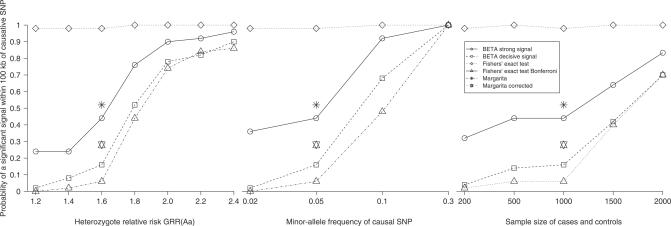
Power for a Range of ModelsProbability of a significant signal within 100 kb of the causal allele. Each point on the x-axis corresponds to 50 datasets under each of the simulation parameters while keeping the rest at their default values. The two points that do not belong to a line correspond to the default scenario for Margarita markerwise p-values calculated by permutation and Margarita experimentwise p-values calculated by permutation. For “BETA strong signal” and “BETA decisive signal” we consider markers with Bayes factors ≥10 and ≥150, respectively.